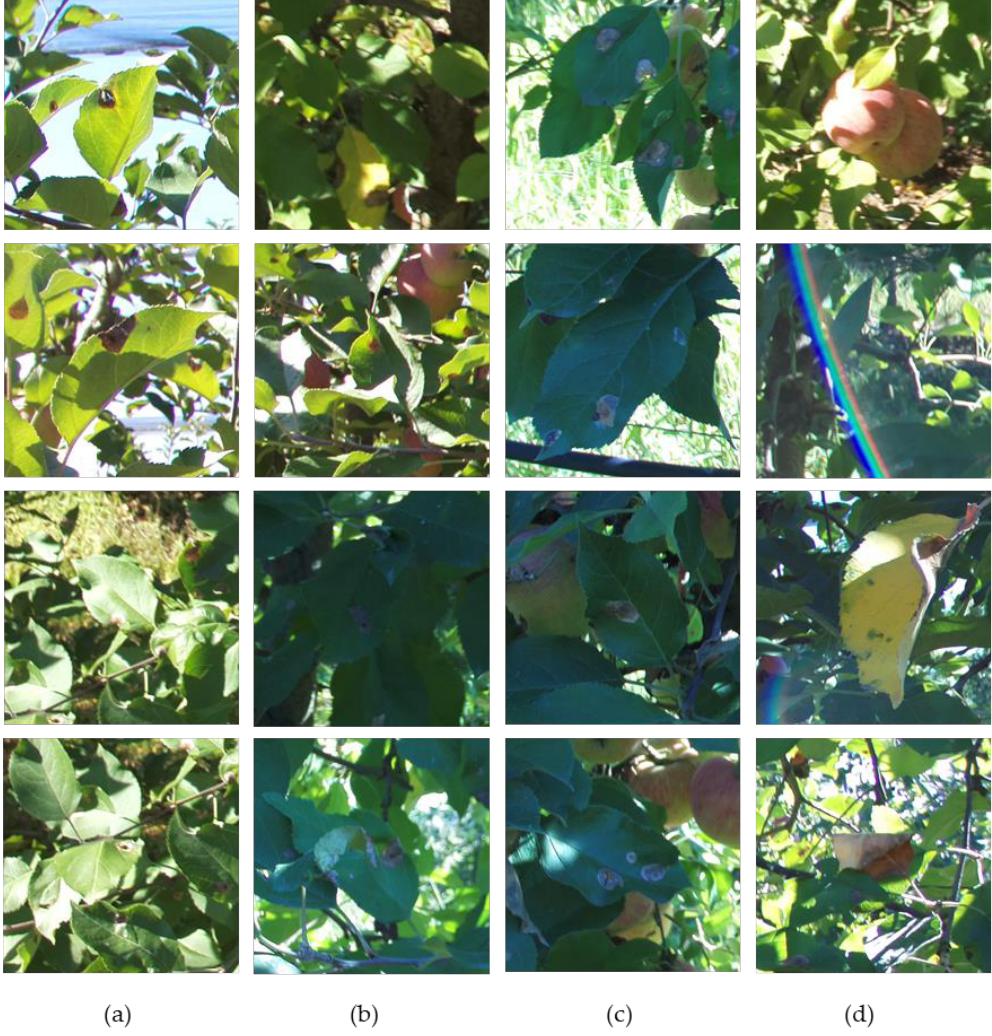
Figure 5. Examples of typical vegetation image segments with sizes of 200 × 200 pixels including damage caused by L. malifoliella ( a – c ); other objects ( d ).